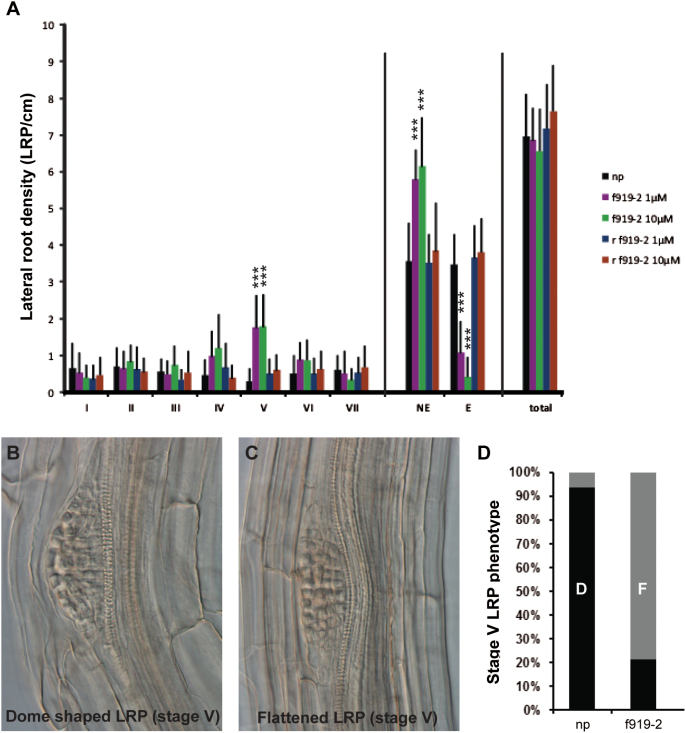
LR-related phenotypes induced by the f919-2 peptide. (A) Distribution of LR developmental stages in roots 12 days after germination. I–VII, primordium stages; NE, non-emerged primordia; E, emerged LRs; total, total number of LRs; np, no peptide; r, randomized peptide. Results for one of two independent experiments are shown (see Materials and Methods). Error bars represent the 95% confidence interval. Asterisks indicate significant differences compared with the no-peptide control (*** P < 0.001). (B, C) Differential interference contrast images of representative stage V LRP-treated (C) or not treated (B) with the f919-2 peptide (10 μM). (D) Relative distribution of the normal and flattened stage V LRP. D, dome-shaped primordia (black); F, flattened primordia (grey) (n = 15–48).